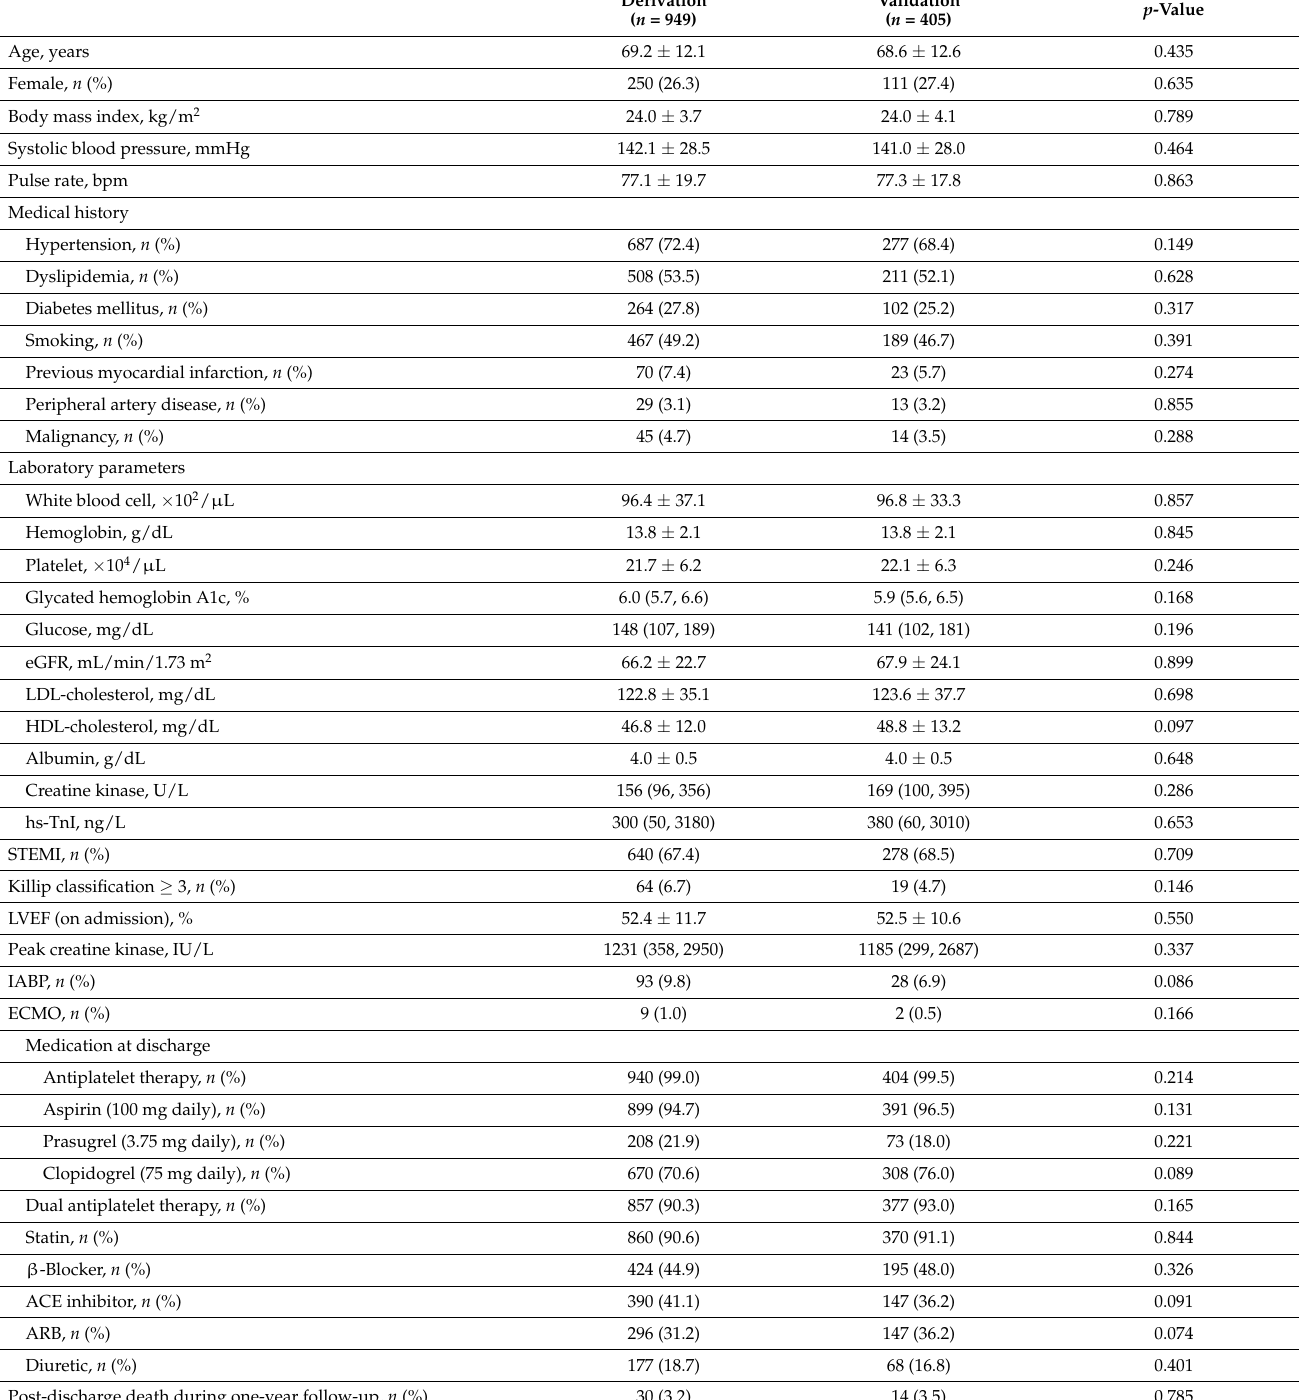
Table 1. Demographics and characteristics in both